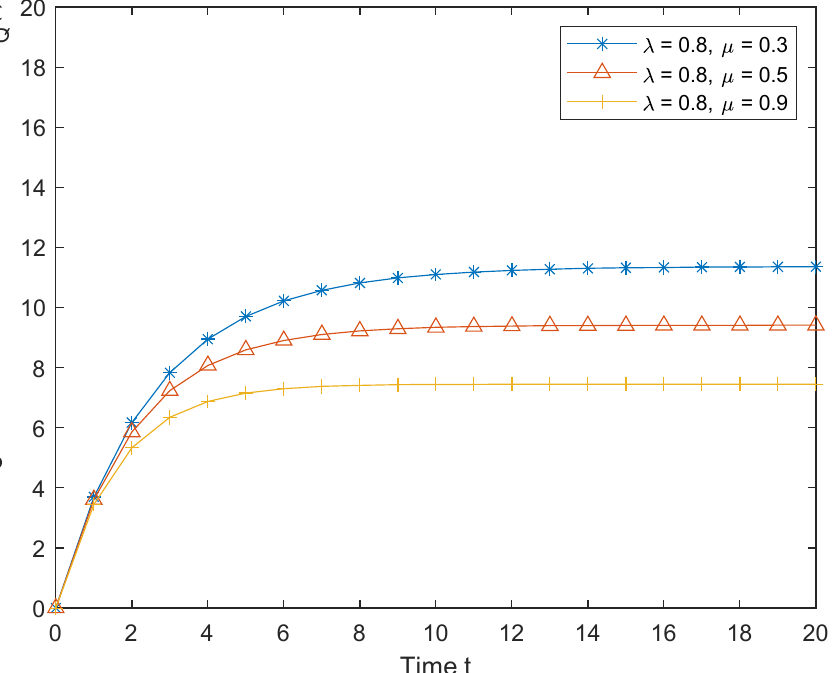
Figure 8. The mean waiting time of customers in the system W S ( t ).